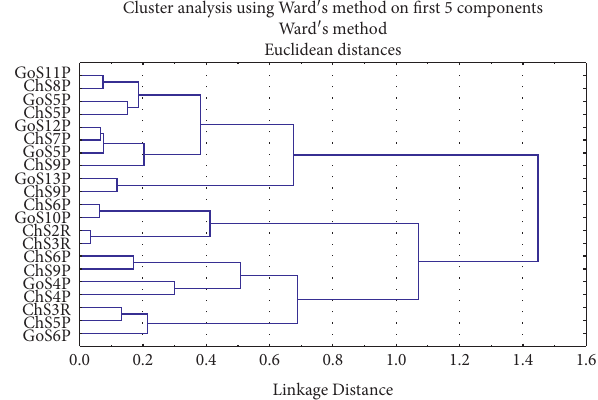
Figure 6: Cluster analysis of the Cheddar-Gouda group ( n � 21) derived from the sorting data. For cheese codes, the Ch refers to Figure 8: Cluster analysis of the “other” group ( n � 19) derived Cheddar and Go refers to Gouda, S1 to S15 refer to the supplier, from the sorting data. For cheese codes, the 1 st 2 letters refer to the and P (pasteurized) and R (raw) refer to the milk cheese type, S1 to S15 refer to the supplier, and P (pasteurized) and R (raw) refer to the milk type. 2D Plot of Row and Column Coordinates; Dimension: 1 x 2 Input Table (Rows x Columns): 23 x 19 Standardization: Row and column profiles Include condition: ″ attribute count ″ ≥20.0